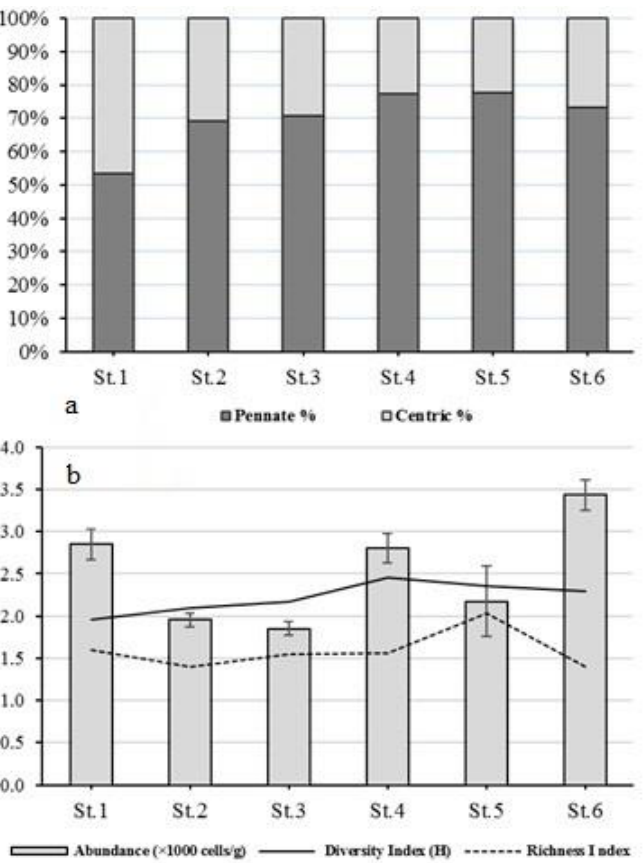
Figure 4. Epipelic diatom population parameters along the study area. ( a ): Percentage contribution of pennate diatom and centric diatom; ( b ): Abundance, diversity (Shannon–Wiener index) and richness (Margalef’s index).